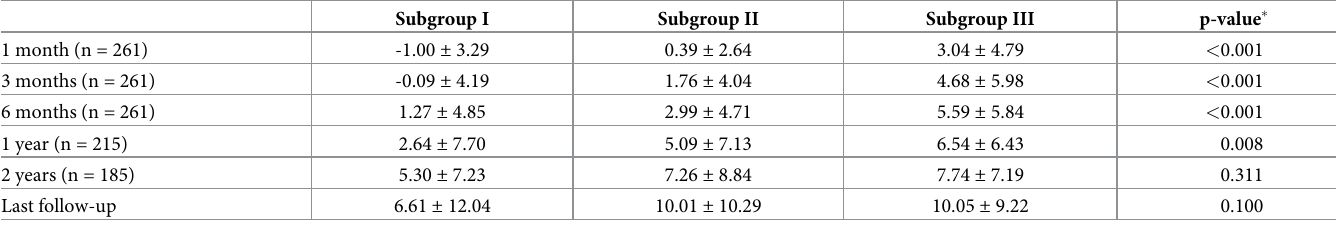
Table 5. Postoperative mean angle of deviation at distance in group O (4–16 years of age) (N =